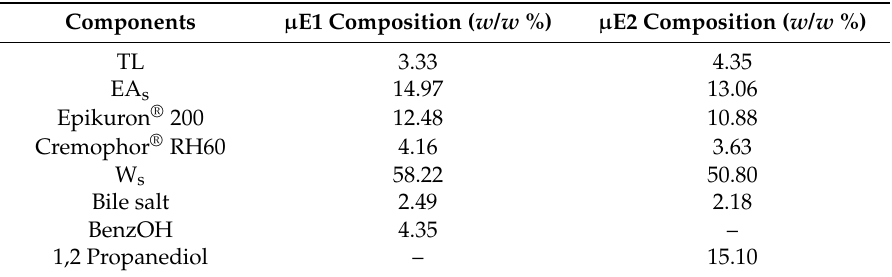
Table 2. µ E composition. µ E1: empty µ E; µ E2: µ E to be loaded with curcumin